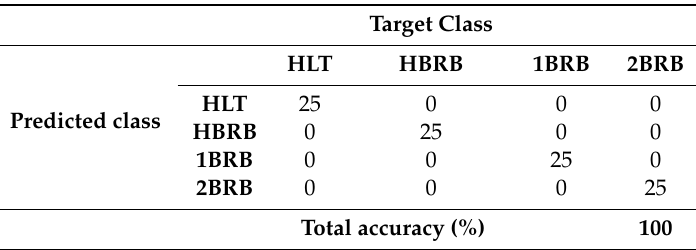
Figure 17. CNN training and validation: ( a ) Accuracy and ( b ) Loss. Table 2. Confusion matrix.